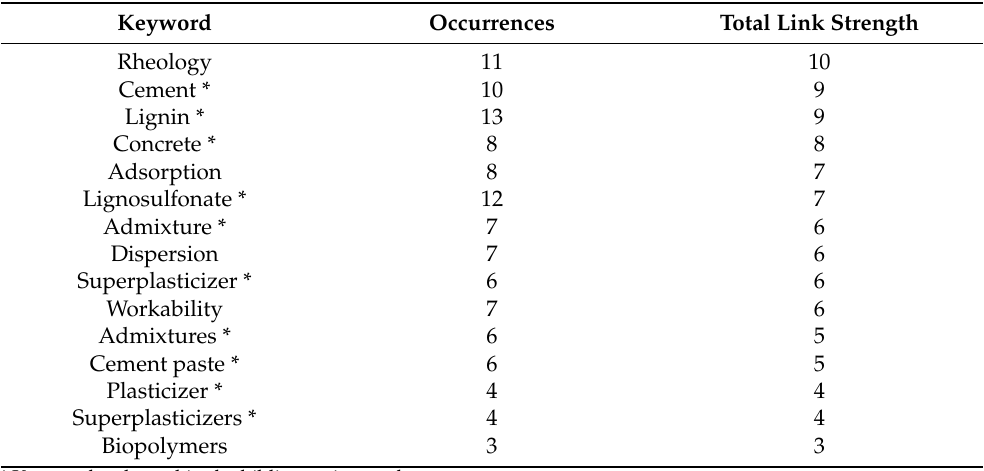
Table 2. Statistical analysis of keywords studied in the LBAs research.